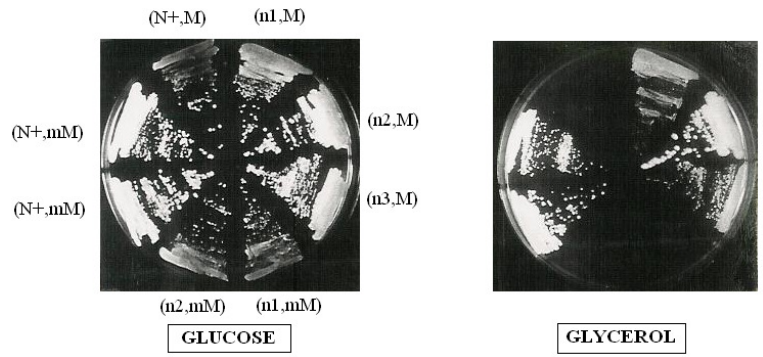
FIGURE 4: Haploid cells carrying both mim3-1 and nam3-1 suppressors are respiratory defi- cient. Fresh cultures of different strains are streaked on YPGA (glucose) and N3 (glycerol) plates and incubated three days at 28°C. All of these strains are isogenic: the nucleus is from JC8 and the mitochondria are from 777-3A. The nuclear genotype is given in brackets (with the nuclear one at the left and the mitochondrial at the right) with N+: NAM3 + , n1: nam3-1;